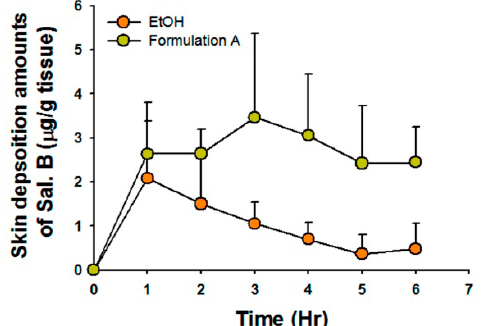
Figure 3. Skin deposition of Sal. B in different vehicles. The skin deposition AUC 0-6 (area under curve 0 to 6 h) of Sal. B/formulation A was significantly higher than that of Sal.